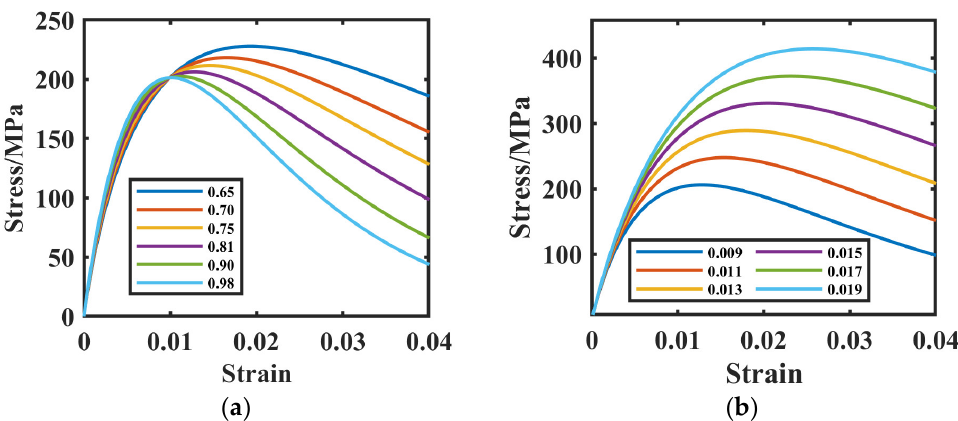
Figure 17. Different constitutive parameters. ( a ) Different n value. ( b ) Different ε f value